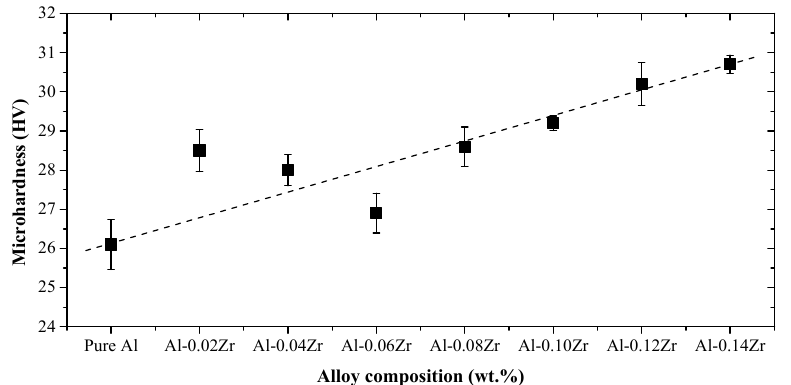
Figure 6. Microhardness number vs. Zr concentration plot.